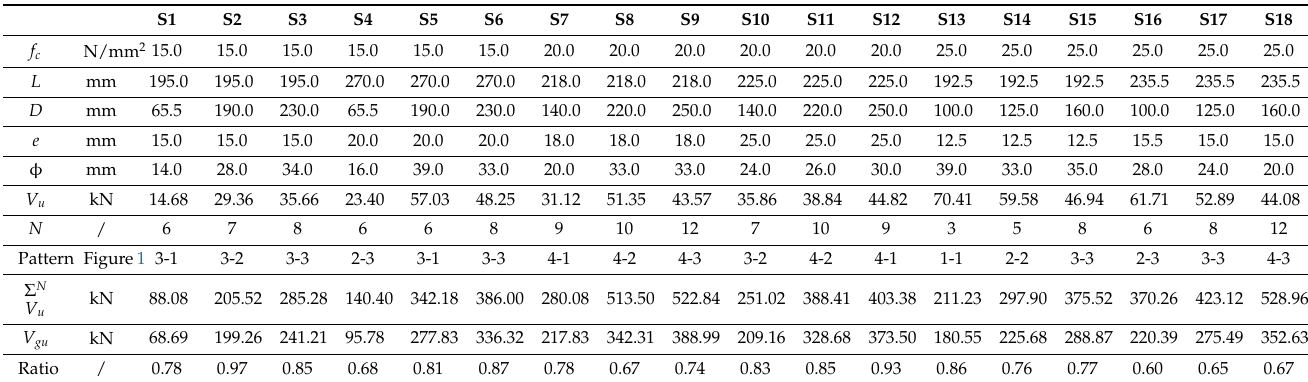
The case studies of Table 1 were further analyzed, in order to point out the difference in strength of the anchors when they are part of a group (anchor group effect) with respect when they do not interact (no anchor group effect, i.e., N independent anchors). That analysis considered all the possible anchor patterns and diameters, and referred to the best combination of diameter and number of anchors that was found for each pattern. The results of that analysis are reported in Table 2. Table 2. Anchor groups versus individual anchors. Exploitation ratios of the 18 case studies of Table 1. The first row recalls the case study of Table 1 (S1–S18). The rows from the second to the fifth exhibit the value of the mechanical and geometrical parameters of each case study, which are those reported in Table 1. The sixth row reports the diameter φ of the anchors of each group. The seventh row reports the shear strength V u of the single anchor post-installed alone (no group effect). The eight row reports the number of anchors of the group and the nineth row reports the anchor pattern with reference to Figure 1 (the first digit is the row, and the second digit is the column of Figure 1). The combination of φ and N is the best for that pattern. The tenth row reports the strength that the anchor group would have if the anchor group effect were zero (no interaction between the N anchors), which is denoted by Σ N V u . According to the definition: Σ N V u = N · V u . The second to last row recalls the results of Table 1, i.e., this row exhibits the shear strength of the anchor group V gu . The last row reports the exploitation ratio, which, for each column, is the result of the second to last element divided by the third to last element. The first and second columns report the symbol of the mechanical and geometrical parameters, and the relevant units. Each column from the third to the last reports a case study completely and shows the role played by the anchor group effect in the shear strength of the anchor